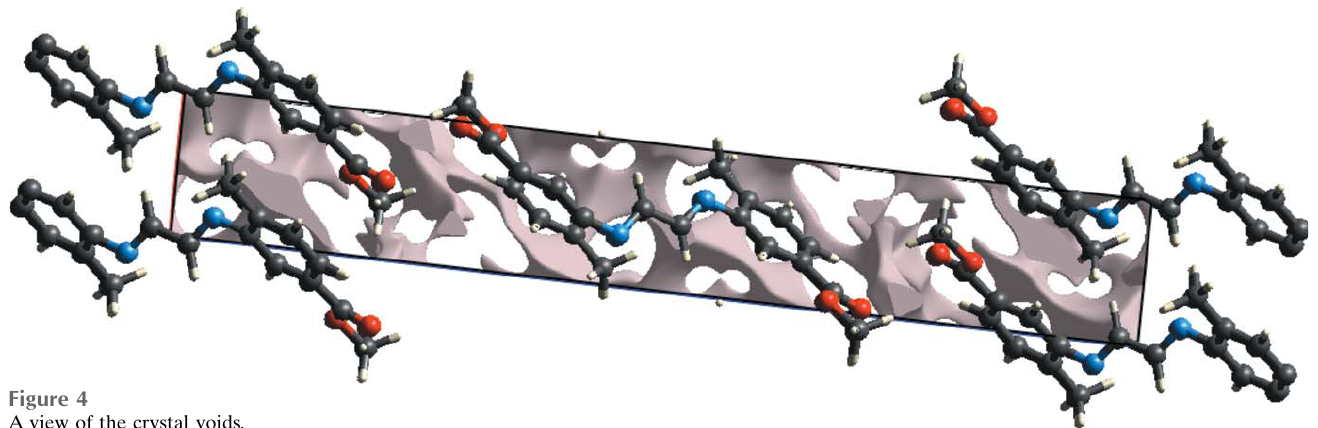
Figure 4 A view of the crystal